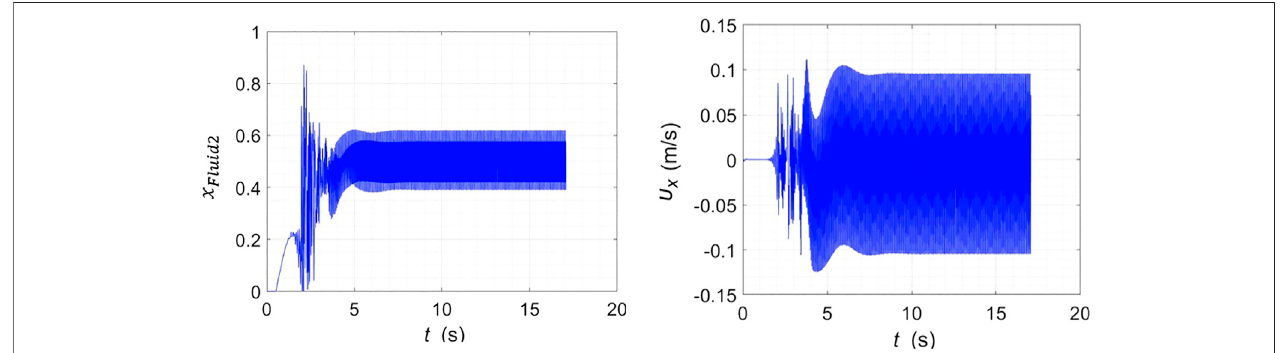
FIGURE14| Average ofthemolarfraction ofFluid1 andFluid2 inthecentreofleft andright channels oftheExtendedNUB geometry,forRe (cid:1) 300between10and 17 s fl owtime.